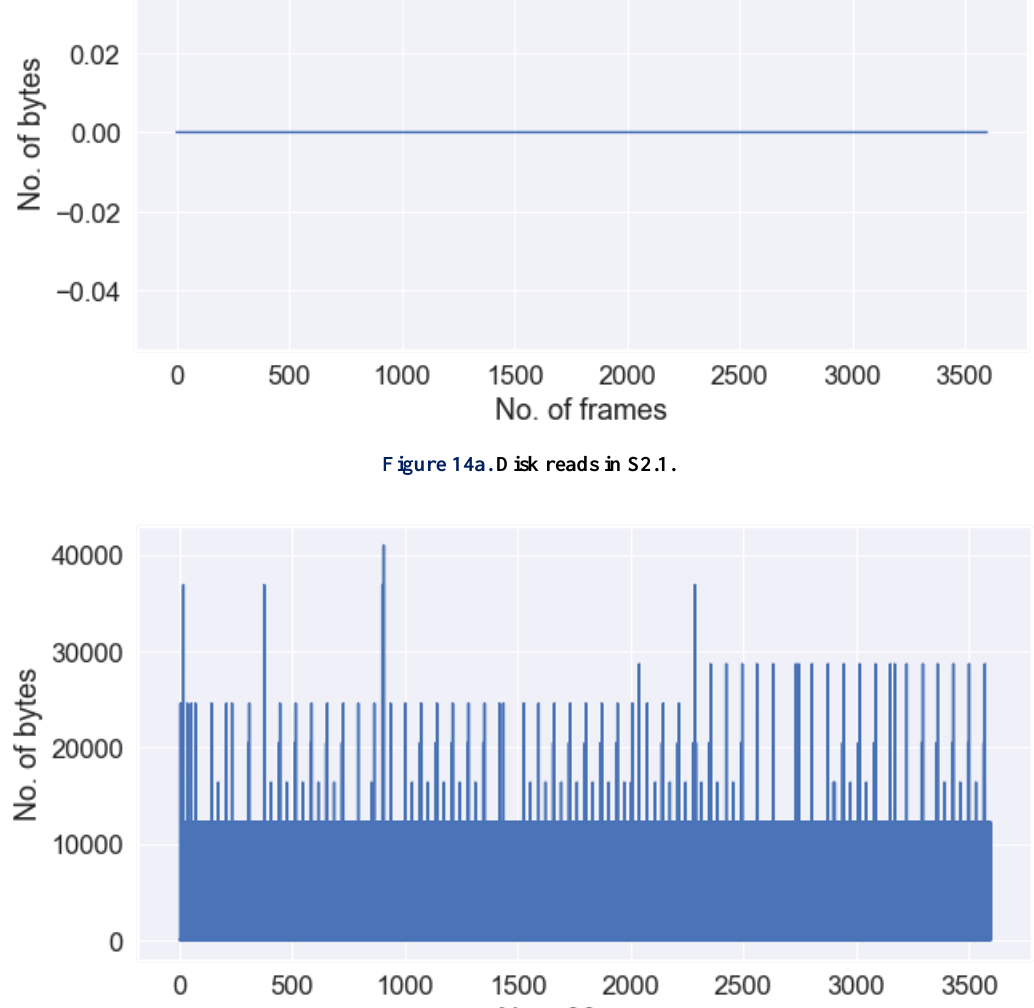
Figure 13. CPU utilization in S2.1.